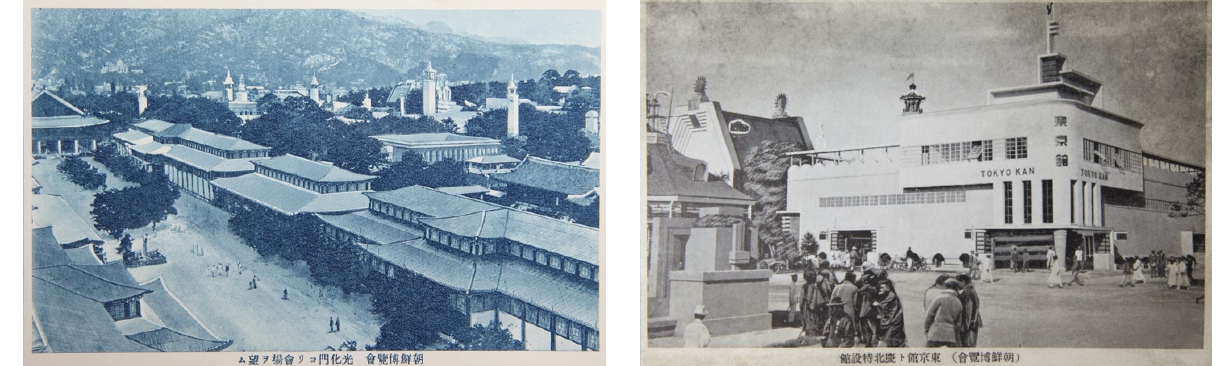
Figure 23. 1929 Joseon Expo at Gyeongbokgung Palace in Seoul, Korea: ( Left ) Pavilions in Traditional Korean Style. ( Right ) Tokyo Pavilion of the in Modern Architectural Style (Source: Seoul Museum of History) [29].